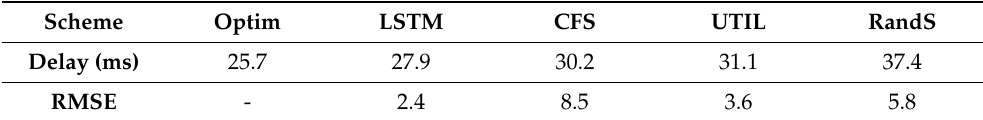
Figure 10. Service Delay with Different EC Capacities (6 EC, 30 Requests, µ = 0.5 and Total Moving Probability is 1). CFS [34]; UTIL [35]. Table 3. RMSE values and service delay in no mobility event ( µ = 1, 6 ECs, 30 requests and EC capacity is